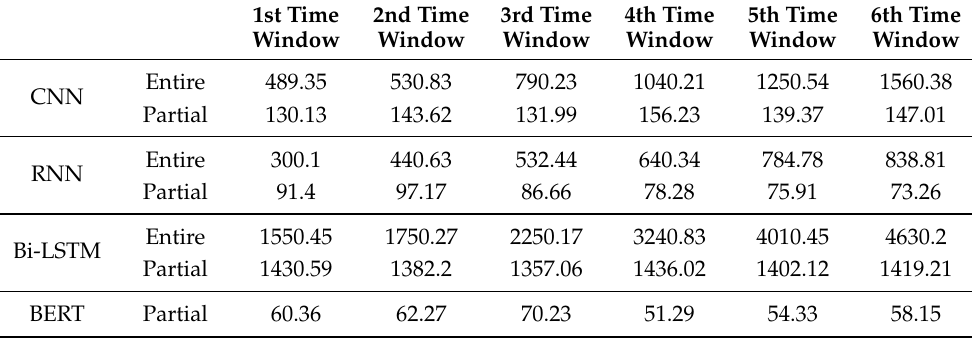
Table 4. The learning time of the proposed strategies on the CSI dataset